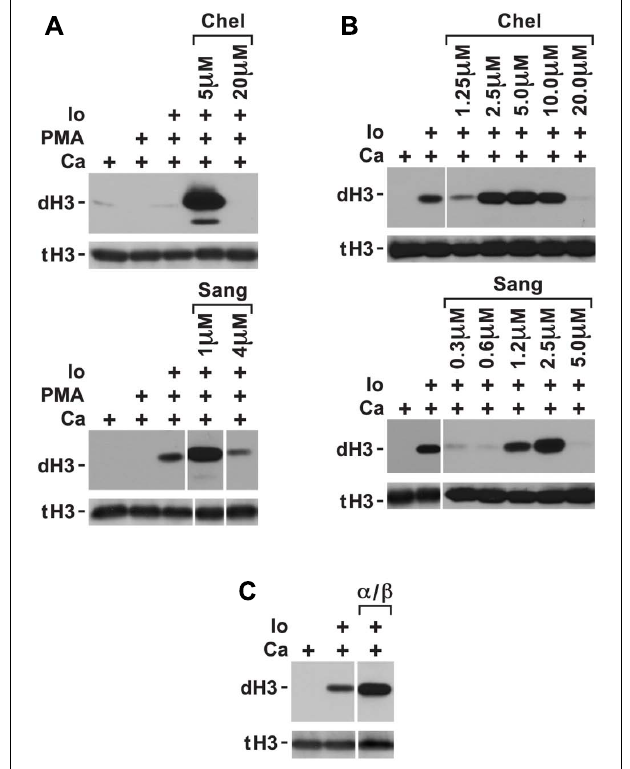
FIGURE 2 | Conditions in which PKC inhibitors enhance histone deimination. (A) Histone deimination that is repressed by PMA can be derepressed by 5 μ M chelerythrine (Chel) or 1 μ M sanguinarine (Sang) but higher concentrations of these inhibitors lead to renewed repression. Levels of deiminated histone H3 (dH3) vs. total H3 (tH3) were estimated by western blotting. (B) A narrow range of inhibitor concentrations also superinduced histone deimination in response to ionophore (Io). (C) Pseudosubstrate peptide inhibitor for PKC α / β enhanced histone deimination that was stimulated by ionophore.The vertical white lines separate lanes from the same gel that were taken with identical autoradiographic exposure but were arranged differently in the original gel. The presence of stimuli is indicated by a plus